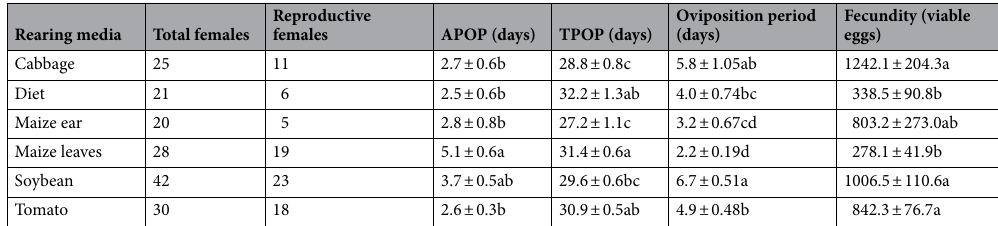
Table 3. Adult preoviposition period (APOP), total preoviposition period (TPOP), oviposition period, and fecundity parameters based on reproductive females of the fall armyworm, Spodoptera frugiperda fed on cabbage, maize ear, maize leaves, artificial diet, soybean, and tomato. Standard errors were estimated using 100,000 bootstrap resampling. Data followed by the same lower-case letter within a column were not significantly different based on a paired bootstrap test at 5% significance